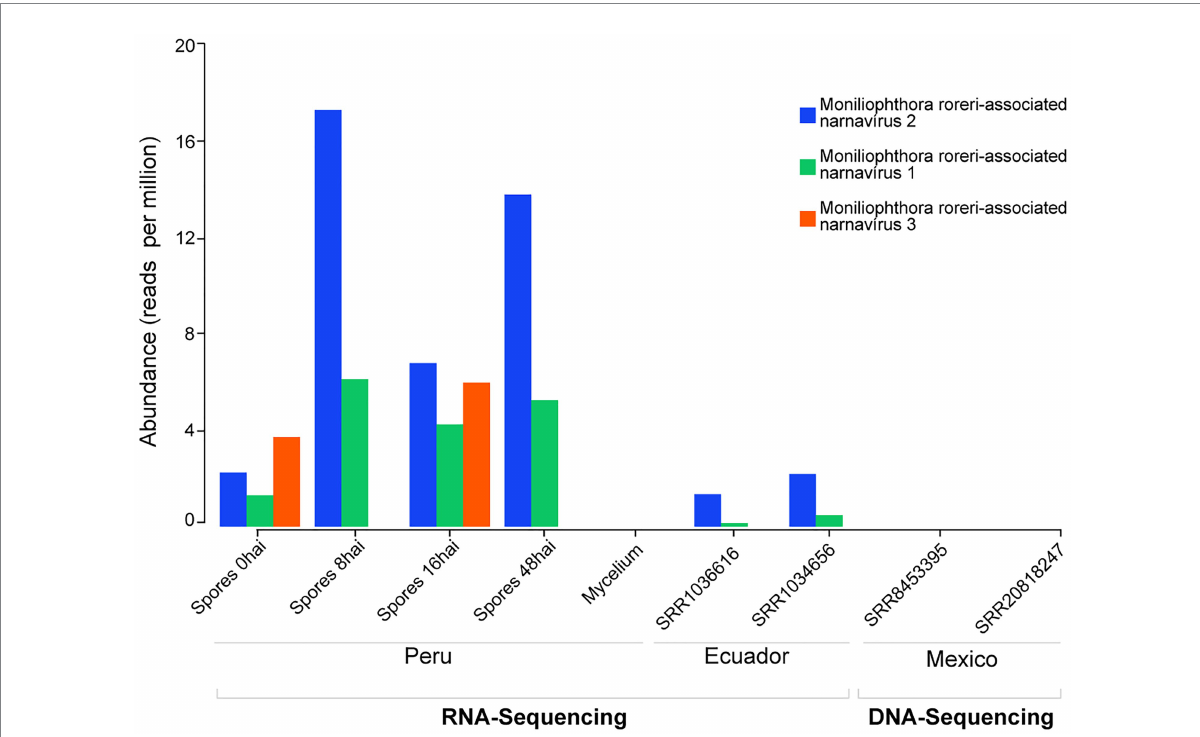
FIGURE 3 Presence of Moniliophthora roreri -associated viral sequences in public datasets. RNA and DNA deep sequencing libraries deposited at NCBI SRA databases from samples originated in different countries were investigated regarding the presence of reads derived from M. roreri -associated viral